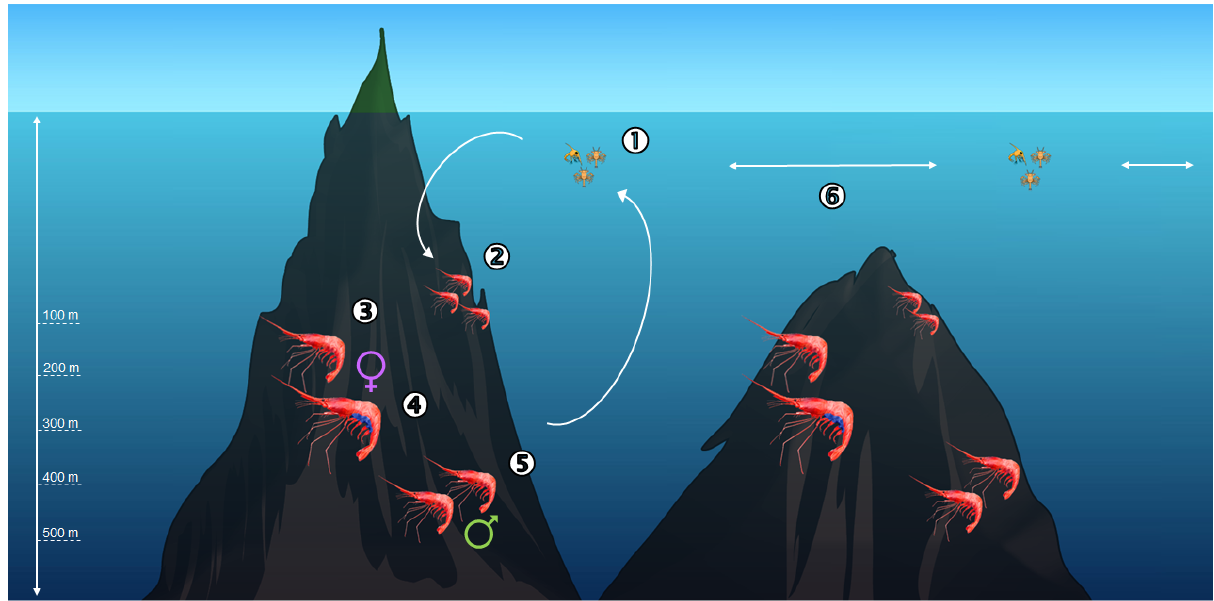
Figure 8. Hypothesized life cycle of Plesionika edwardsii in the Azorean region. After the incubation period of shrimp eggs, ( 1 ) larvae are released into the water column and ( 2 ) juveniles develop in shallow waters. Mature females and males are distributed up to 600 m with a sexual segregation by depth: ( 3 ) non-ovigerous females are mainly found up to 200 m, ( 4 ) ovigerous females between 200 and 300 m, and ( 5 ) males from 400 to 500 m deep. Females are bigger than males, and ovigerous females are bigger than non- ovigerous females. A bigger-deeper trend is observed up to 400 m. ( 6 ) Long larval stages of P. edwardsii increases its potential for dispersal (Landeira et al. , 2009), favoring connectivity and stock homogeneity between adjacent